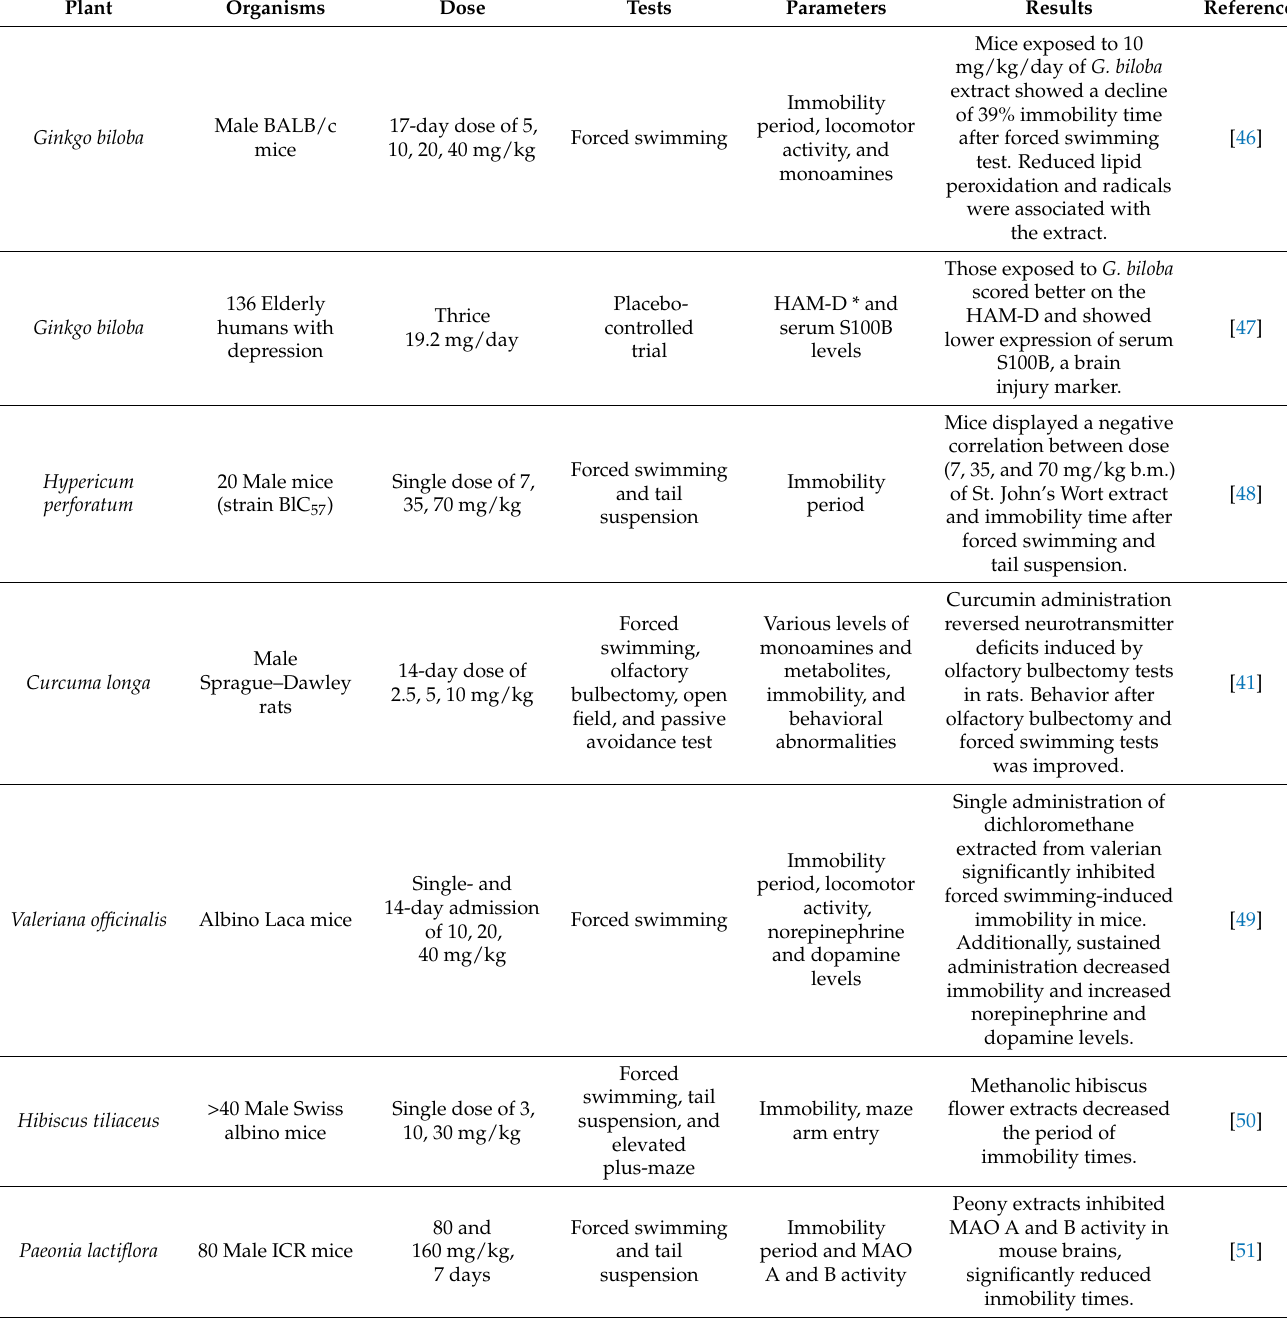
Table 2. Overview of experimental trials on anti-depressant functions of officinal